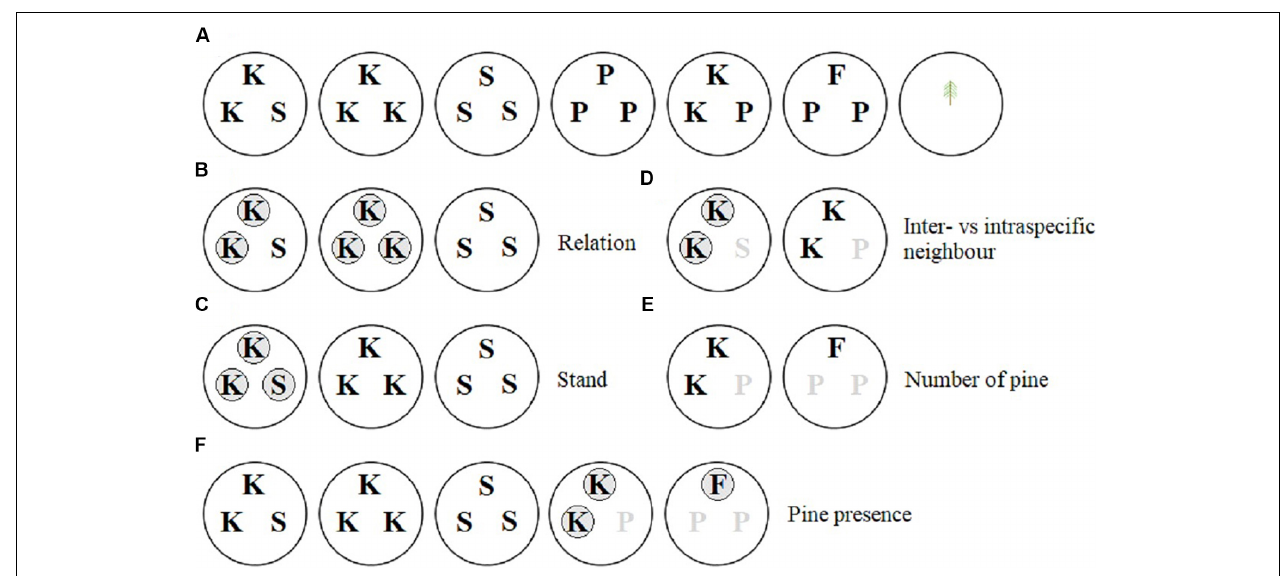
FIGURE 1 | Greenhouse pot organization to examine neighbor effects on interior Douglas-fir. P = lodgepole pine, S = stranger Douglas-fir, K = kin Douglas-fir, F = Douglas-fir (in the Douglas-fir/pine neighbor treatment). Each of three Douglas-fir families were equally represented and the lodgepole pine seedlings were replicated five times in panel (A) . The pure pine and single seedling pots were not used in the analyses of Douglas-fir seedlings. The pure pine was used in the pine seedling analyses (as well as Kin/Pine and Douglas-fir/Pine) and all pots were used in the family analysis. Panels (B–F) represent the contrast set ups. Unshaded seedlings were compared with shaded seedlings of the neighbor treatments shown. When seedlings present in a pot were omitted from the contrast they are indicated by a gray